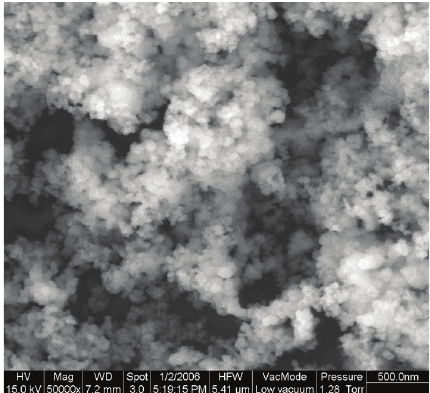
Figure3:TheSEMmicrographof 𝛾 -Fe 2 O 3 powderpreparedat60 ∘ C for 6